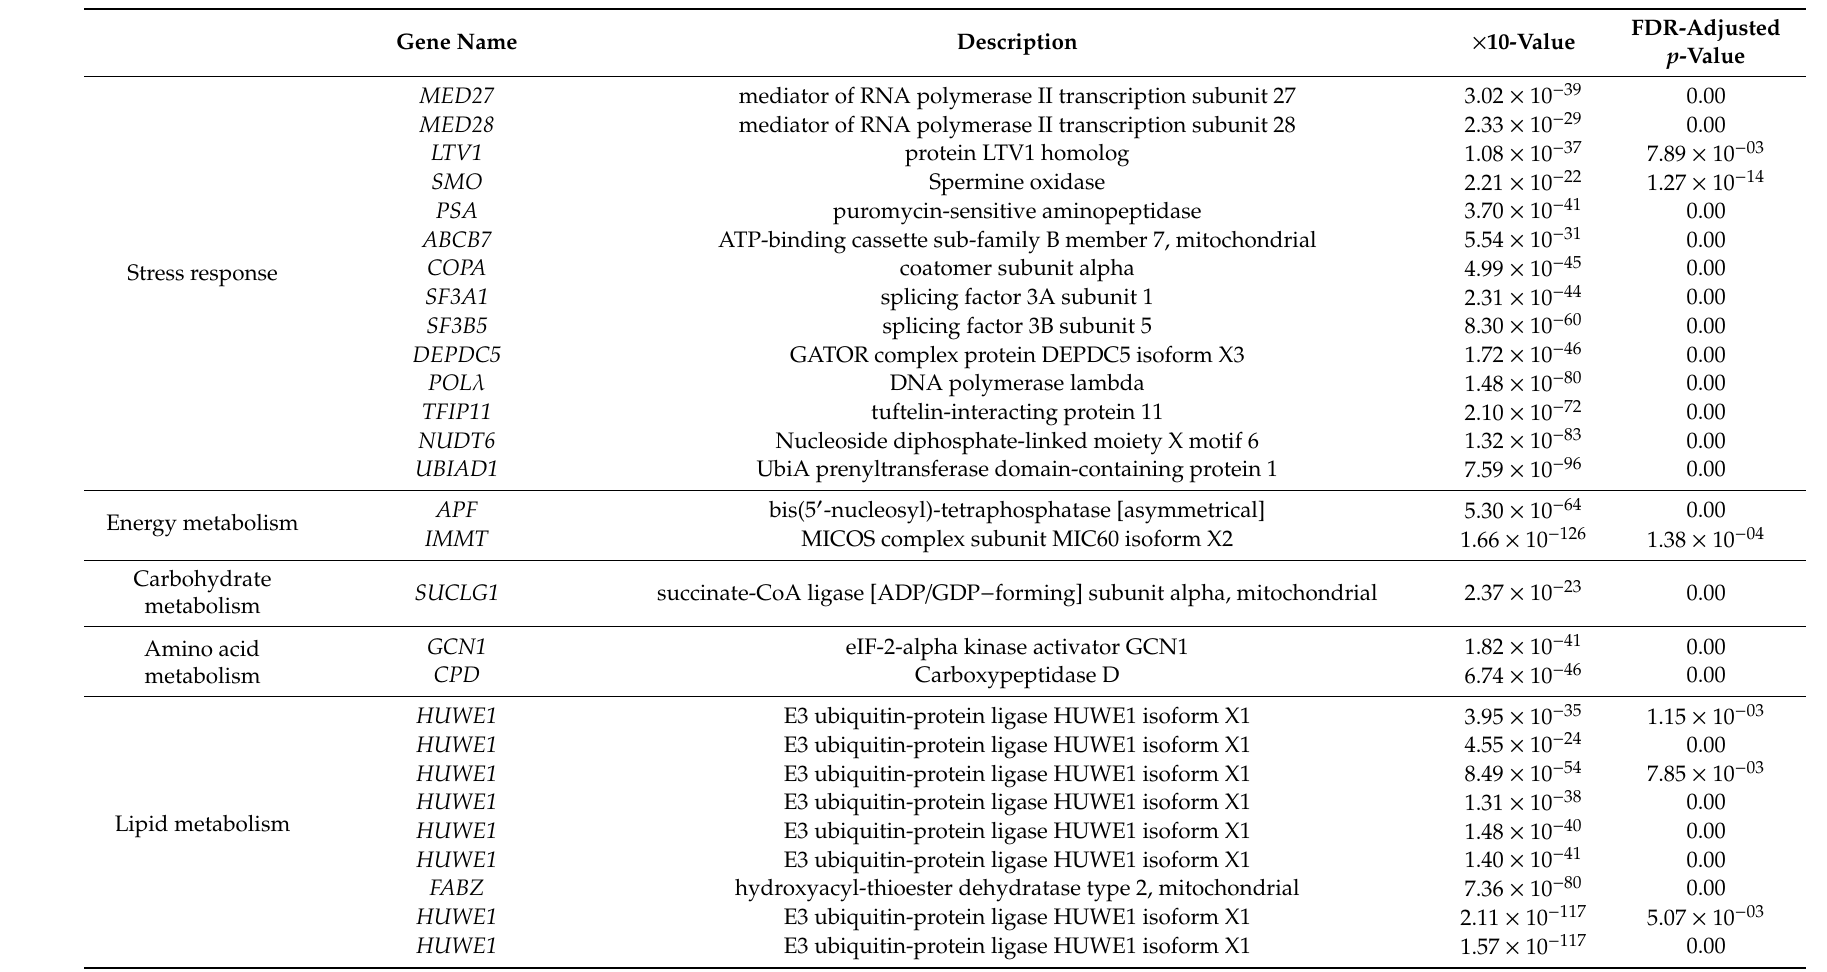
Table 4. Representative positively selected genes in Sillago